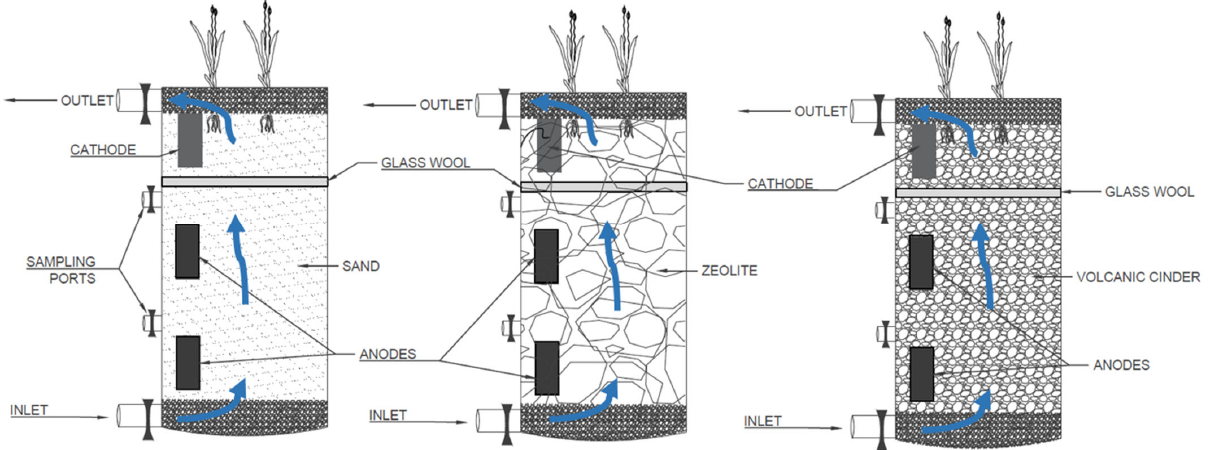
Figure 9. Representation of three parallel up ‐ flow CW ‐ MFC systems (UCW ‐ MFC) ( adapted from Yakar et al. (2018) [61]). Yadav et al. (2020) [73] designed a drip Hyp ‐ MFC system with multiple small reac ‐